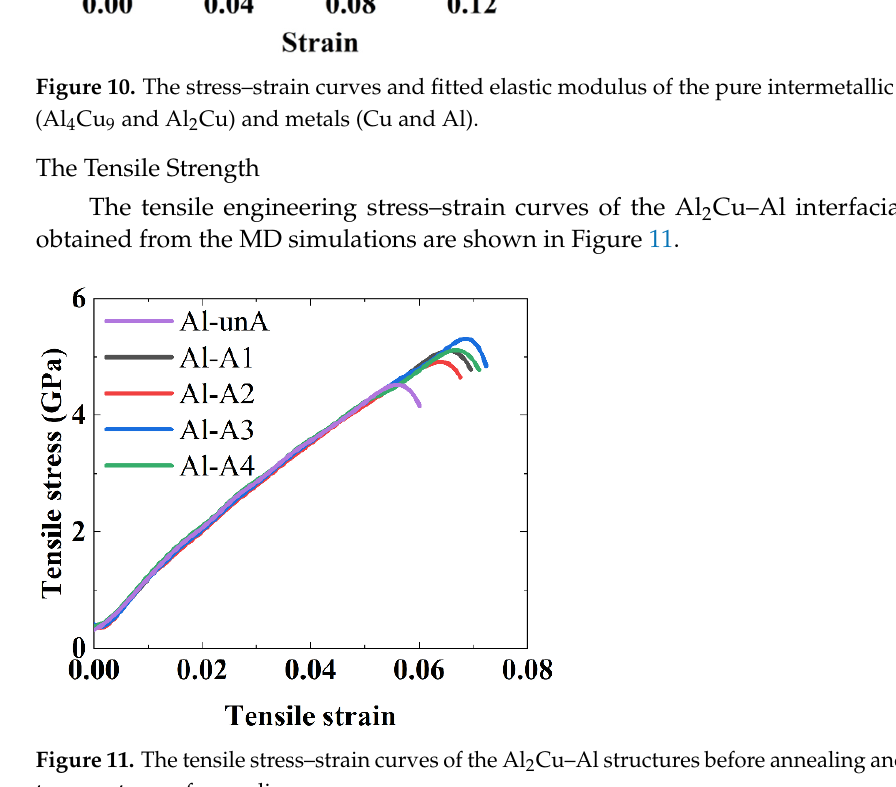
Figure 10. The stress–strain curves and fitted elastic modulus of the pure intermetallic compounds (Al 4 Cu 9 and Al 2 Cu) and metals (Cu and Al).